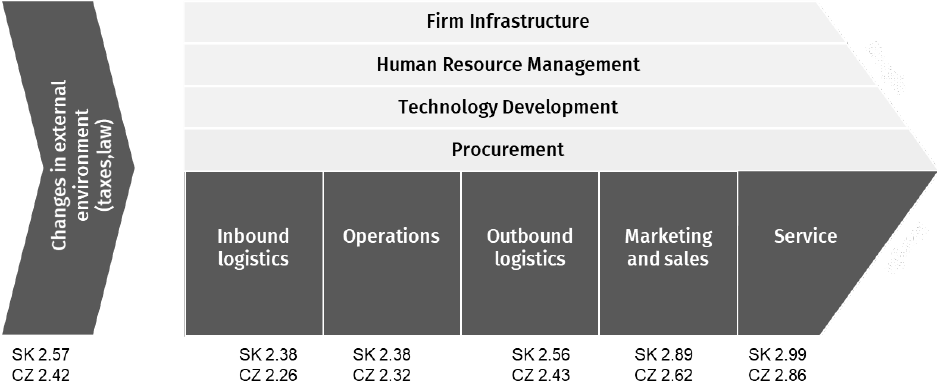
Figure 4. Average assessment of value chain model activities of SK, CZ companies.